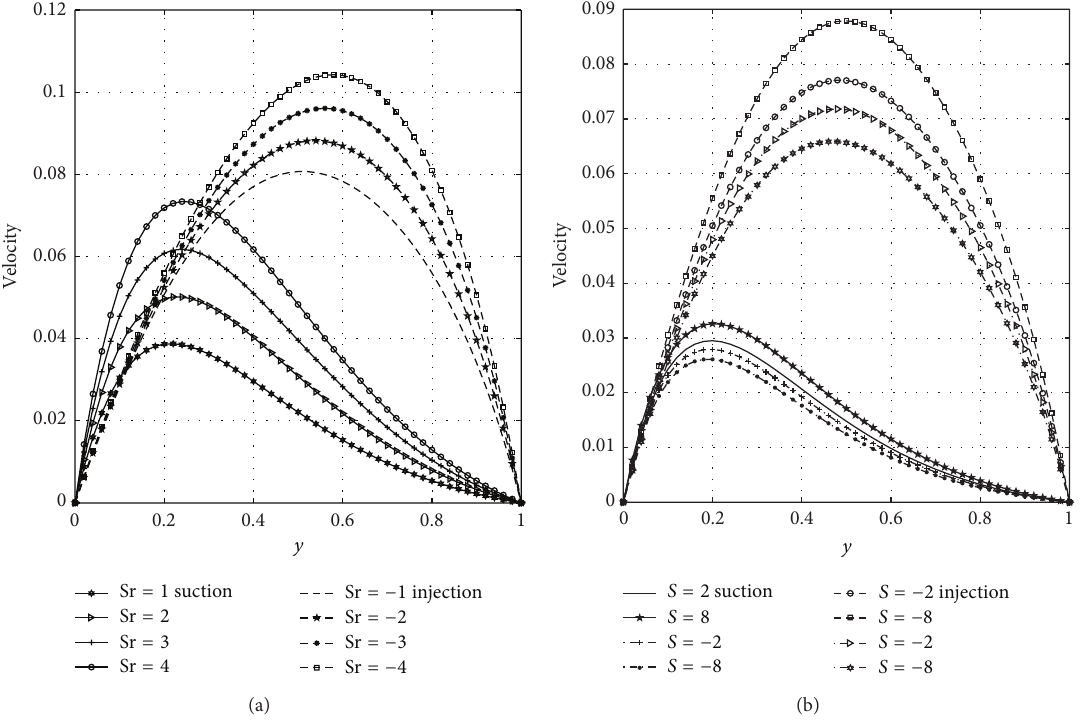
Figure 5: Effects of Soret number (Sr) and heat source/sinks (𝑆) on velocity.